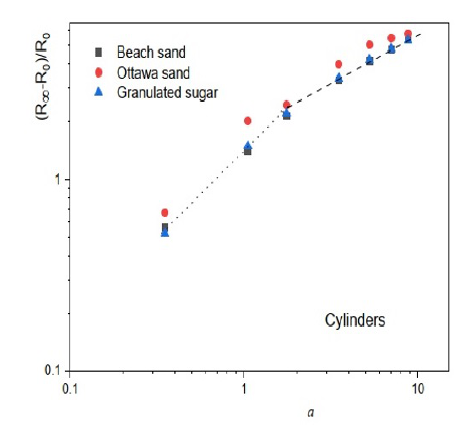
Figure 3. Log-log plot of the dimensionless runout distance versus a for conical columns of several types of materials. Formula (4) fits, on average, data (dotted and dashed lines). Figure 4. Log-log plot of the dimensionless runout distance versus a for cylindrical columns. Formula (5) fits, on average, data (dotted and dashed